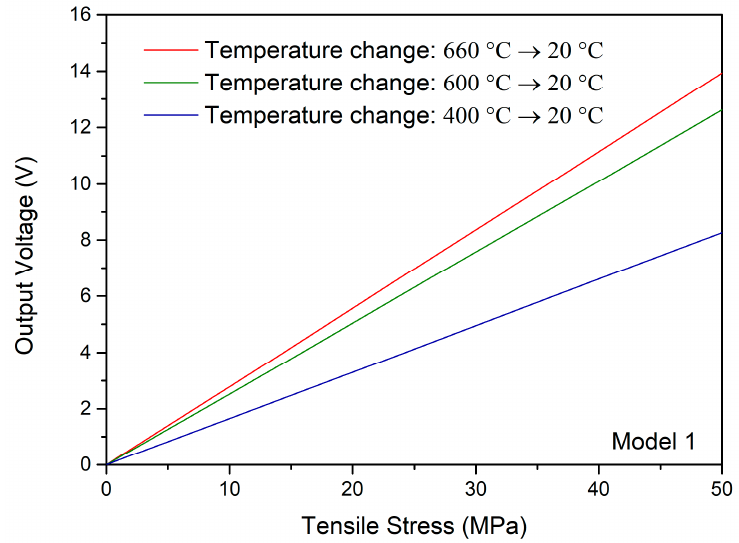
Figure 7. Output voltages versus applied tensile stress for the composite (Model 1) after the temperature decreases from 660 °C (melting point of pure Al), 600 °C or 400 °C to 20